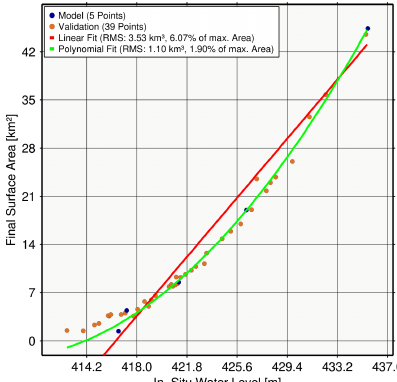
Figure 18. Relation between water level and surface area (hypsometry) used for cross-validation at Poço da Cruz Lake. The blue points (10% of all points) are used for the function fitting, the orange points for the validation. The two fitted curves are plotted in red (linear fit) and green